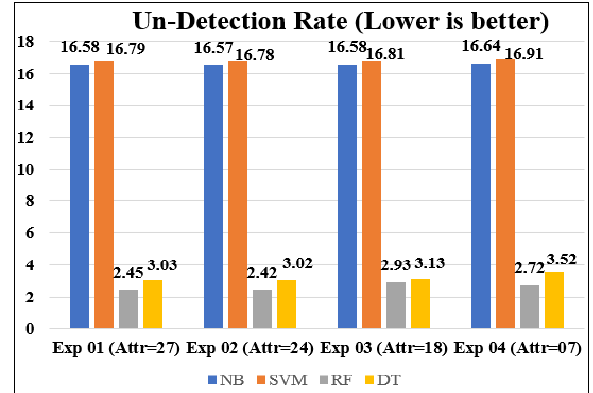
Figure 8. Un-Detection Rate